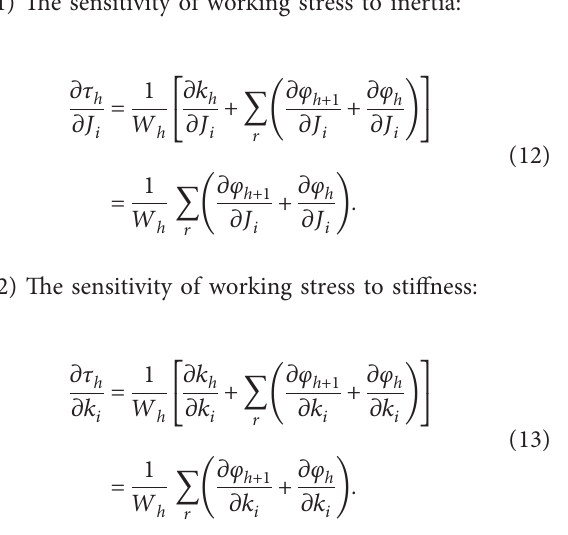
4th-order vibration modes from gear 3 to gear 4.